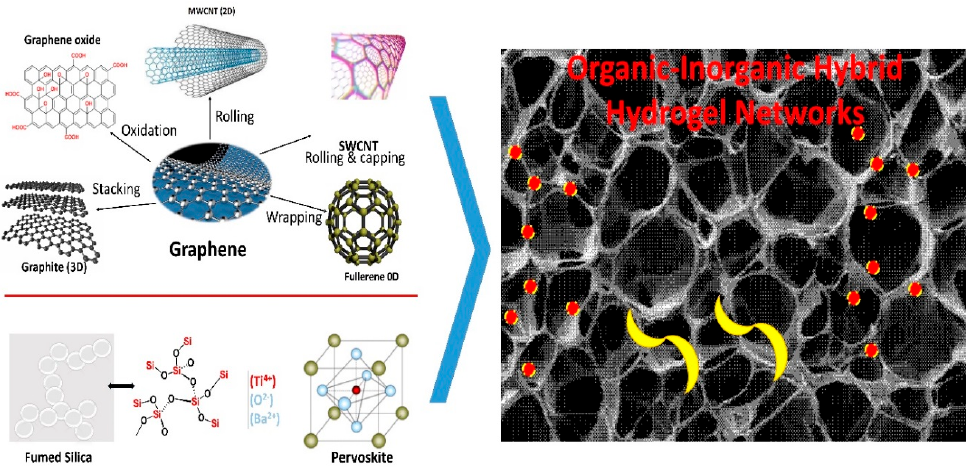
Figure 2. Illustration of potential nanofillers such as 0D (fullerene, C60), 1D small-walled